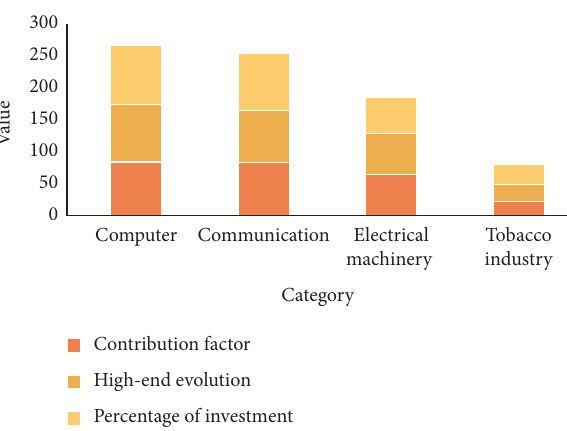
Figure 4: Results of some code of some